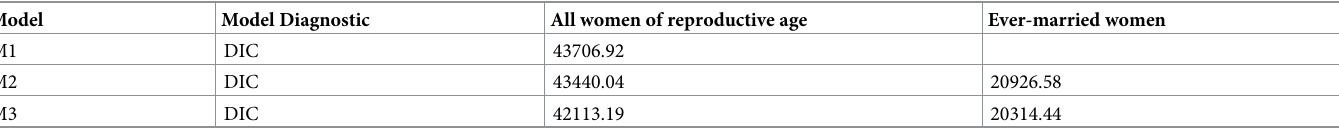
Table 3. Summary of model diagnostic criteria.